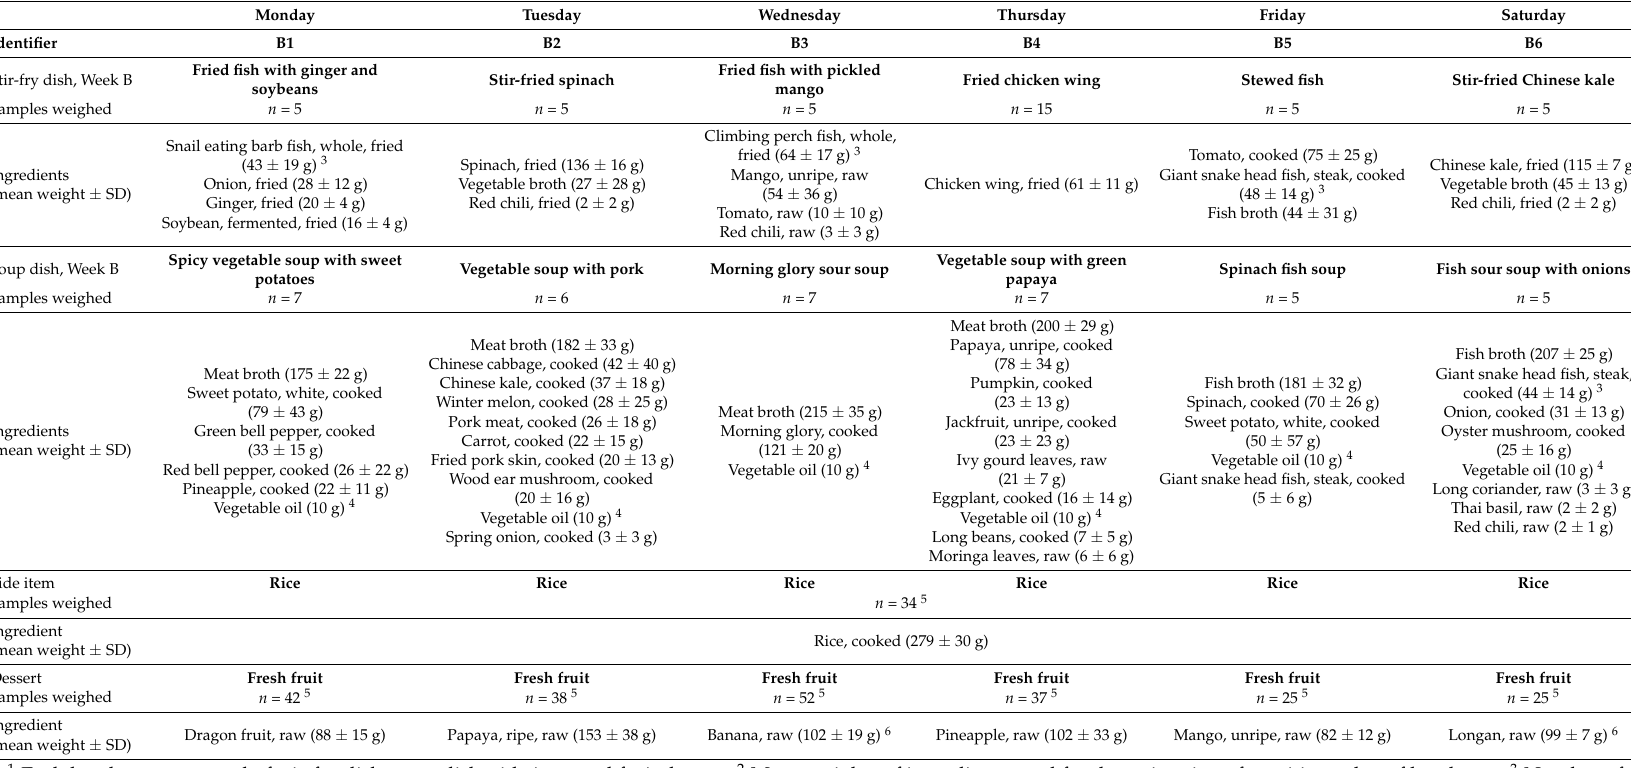
Table A2. Amount by weight of ingredients in low-price model lunch sets served at a garment factory in Phnom Penh, Cambodia (Week B).